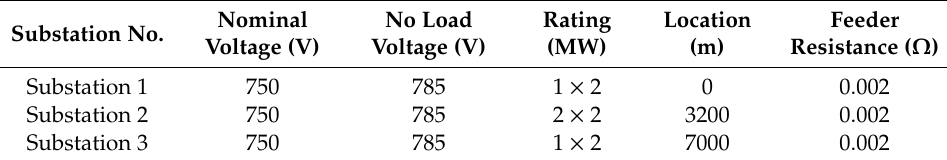
Table A1. Substations input parameters.